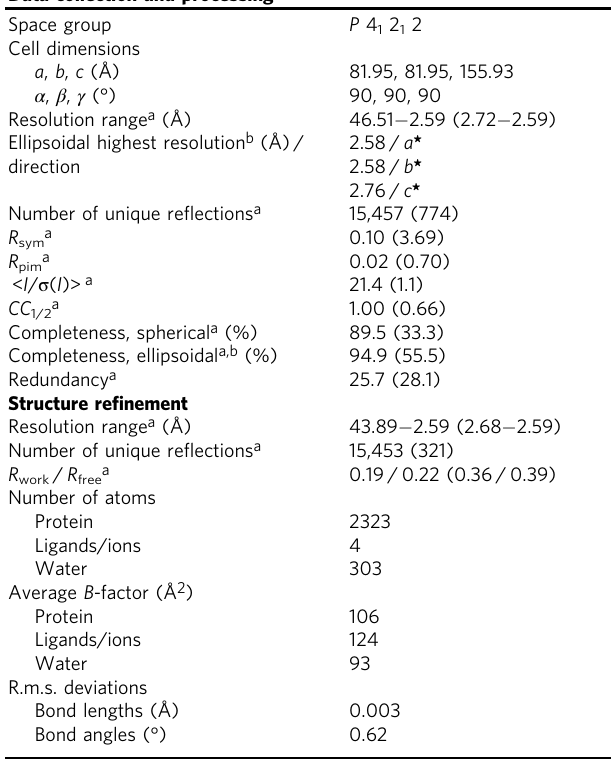
Table 1 Crystallographic data collection and re fi nement statistics.